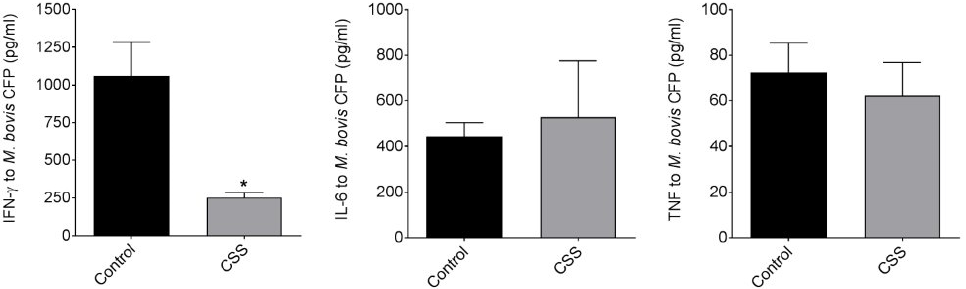
Figure 4. Cont. Figure 4. Cont.